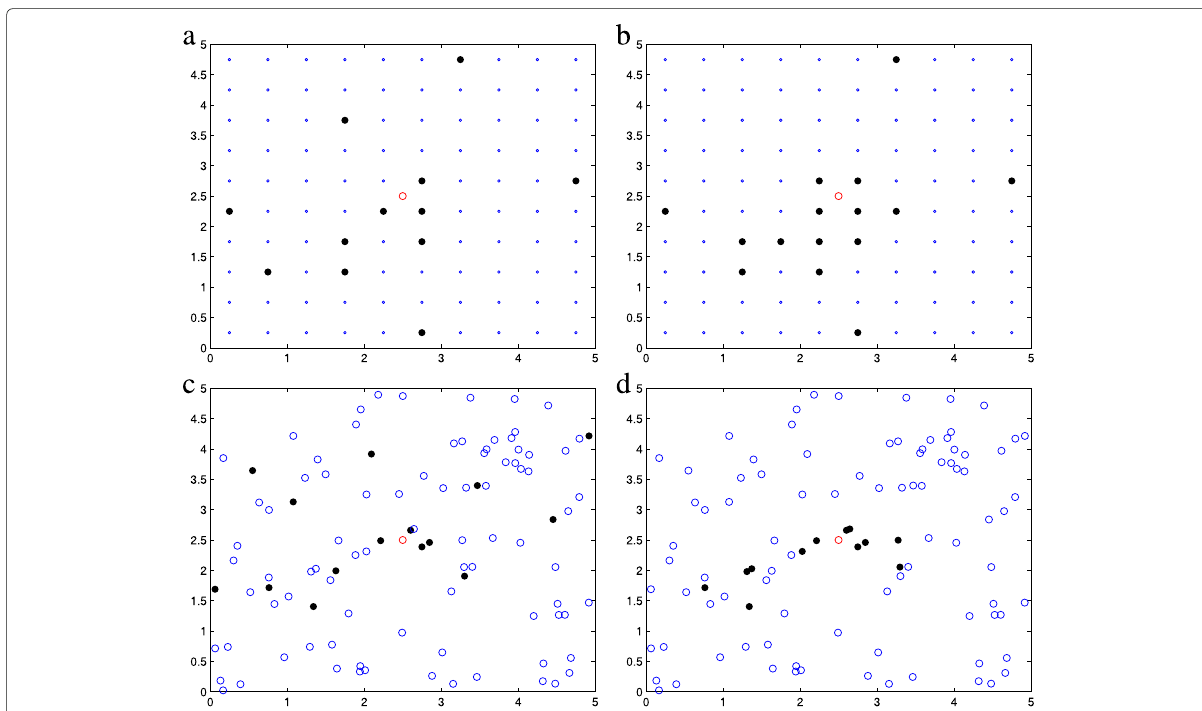
Fig. 1 Ordinary versus Local vote decision fusion under different deployment. After local vote, the number of sensors ( blackdot ) that detected the target ( reddot ) has increased. a , b grid deployment, c , d random